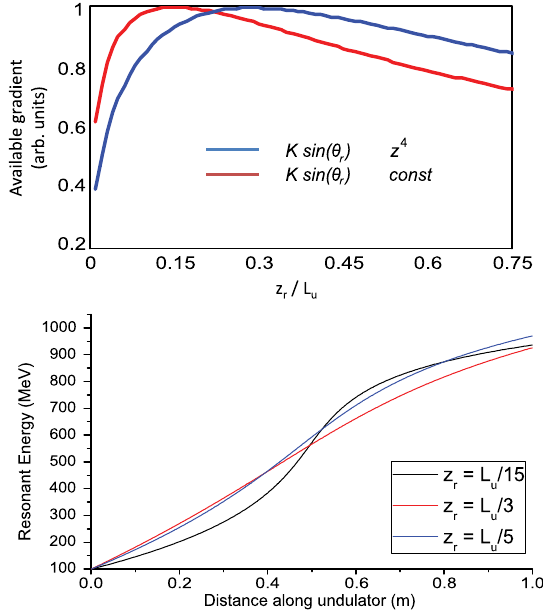
FIG. 2. Left: Available gradient vs normalized Rayleigh range for two different tapering schemes. Right: Resonant energy as a function of undulator length for three different ratios z maximum final energy is achieved for a Rayleigh range of L